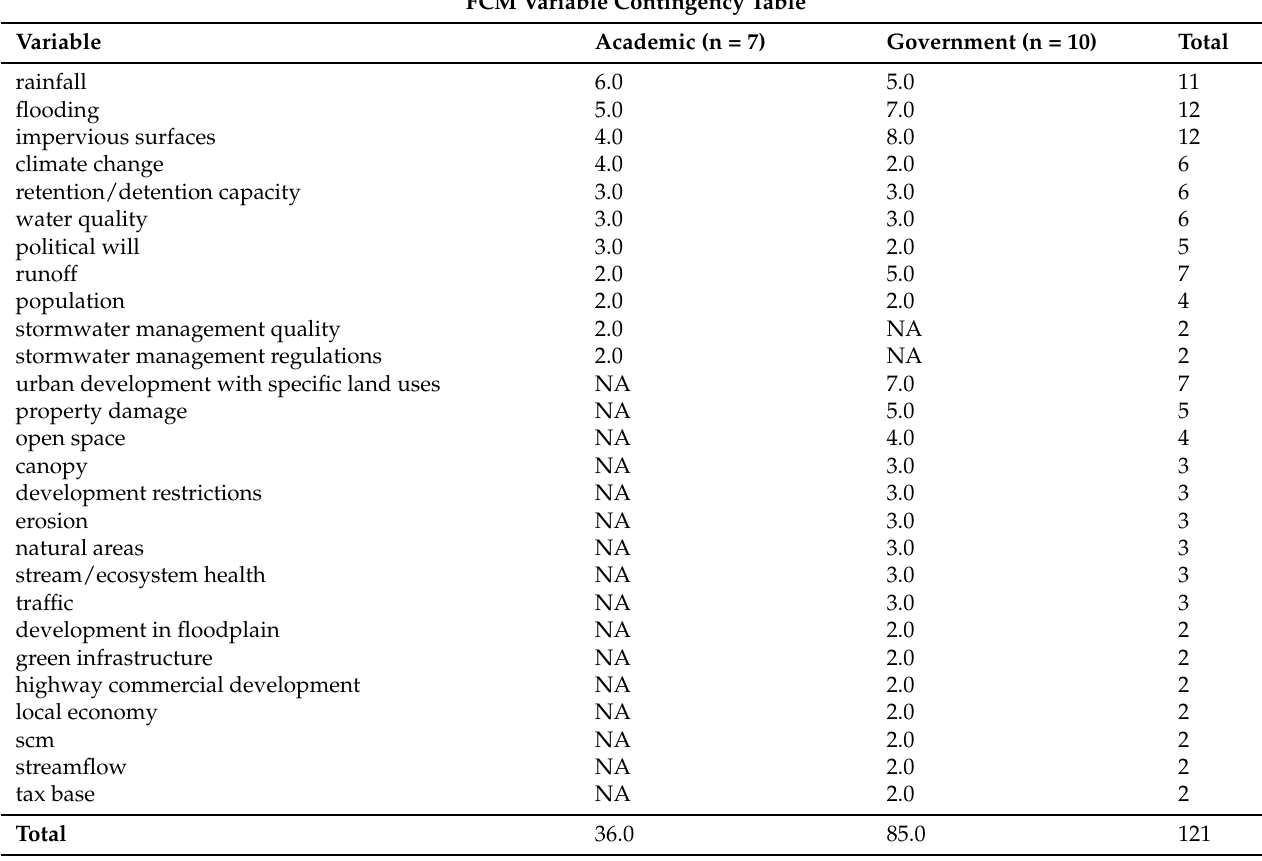
Table A1. When comparing academic and government stakeholder FCM variables that were mentioned more than once using Pearson’s Chi-Square Test, we find that there is a significant relationship ( α < 0.05) between the stakeholder group and variables selection ( p =